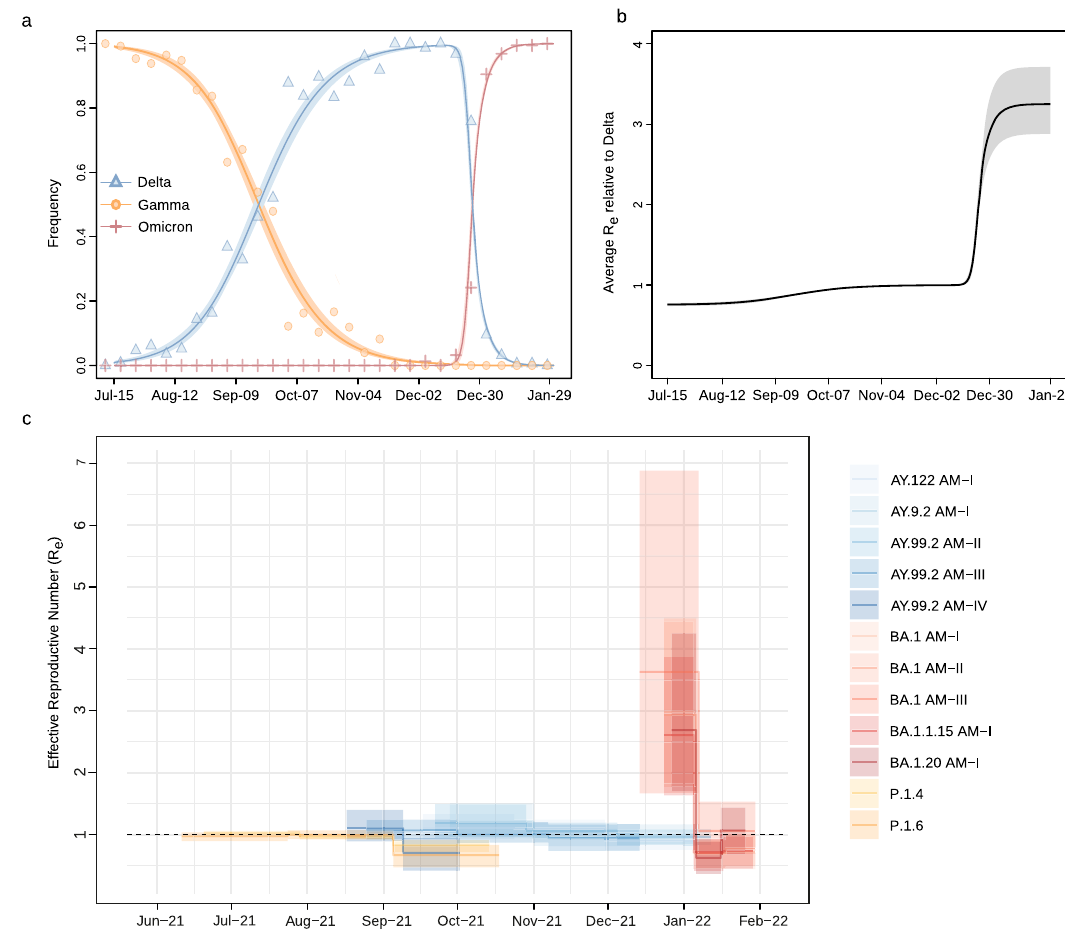
Fig. 7 | Relative R e ofSARS-CoV-2 VOCs in Amazonas. a Observed and estimated frequencies of SARS-CoV-2 variants in the Amazonas state. Circles, triangles, and plus signs represent weekly observed frequencies of Gamma, Delta, and Omicron BA-1, respectively. Red, blue, and orange solid lines are estimated average fre- quencies of Gamma, Delta, and Omicron, respectively, and paled-colored areas represent their 95% con fi dence intervals. b The estimated average relative R e of